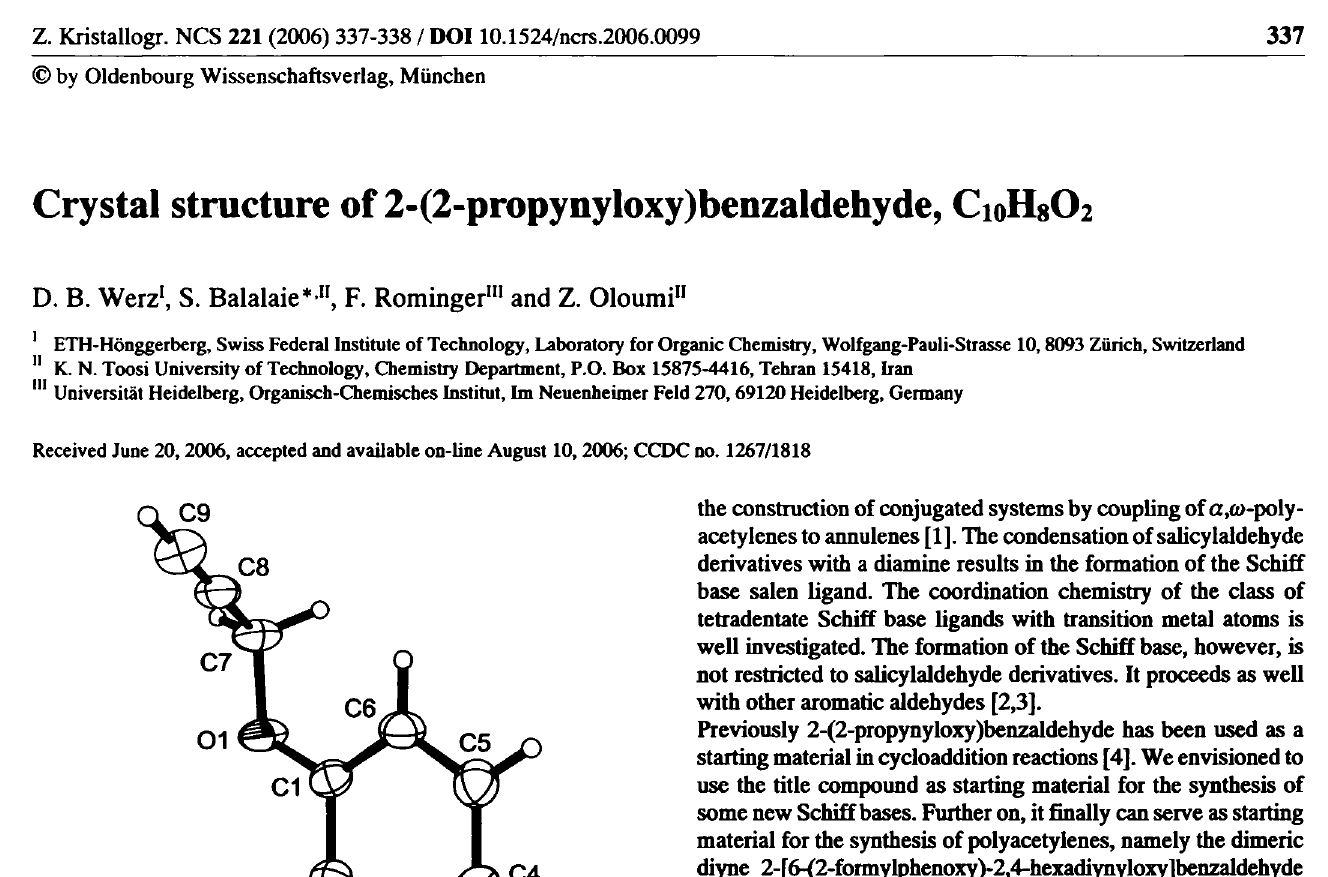
Table 1. Data collection and handling.